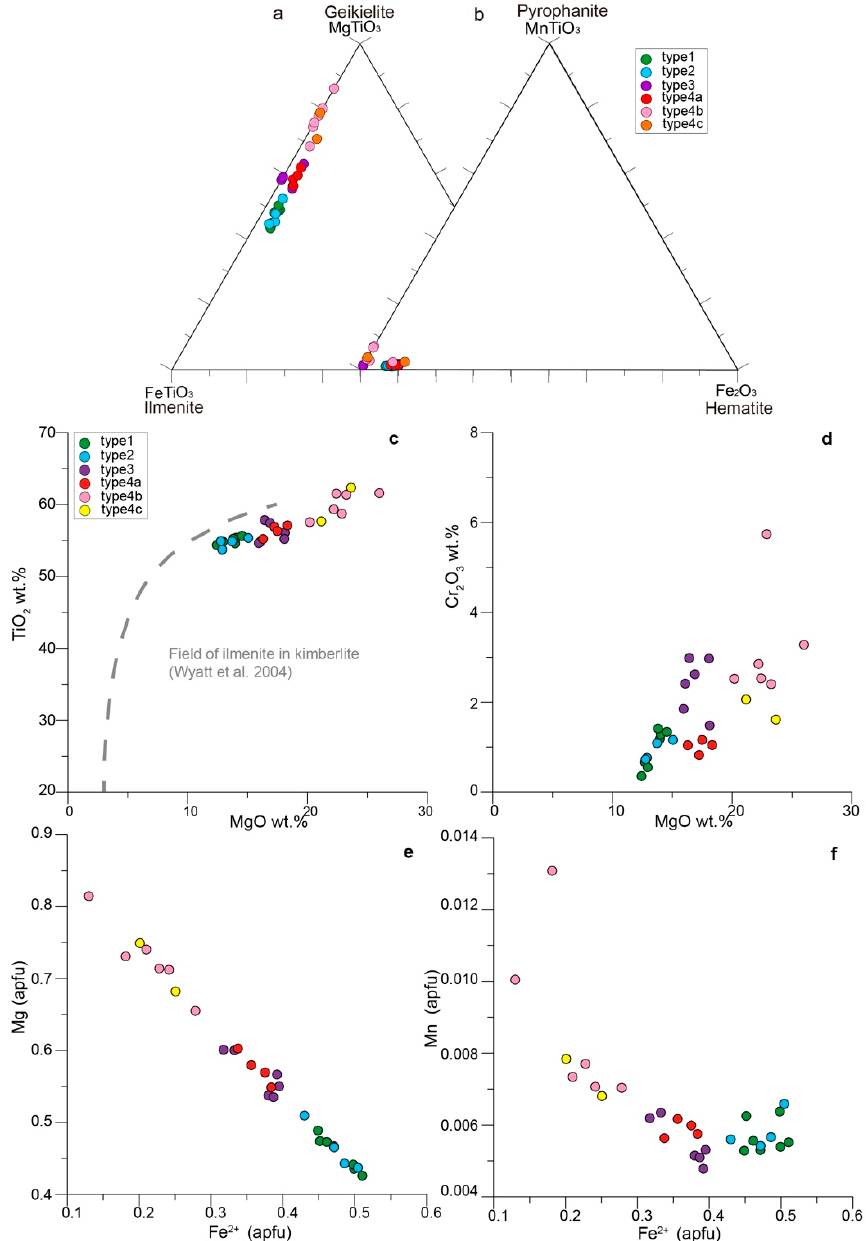
Figure 5. Composition of ilmenite-group minerals. Ternary plots of the di ff erent textural types (1 to 4) of ilmenite from Menominee: ( a ) in terms of the geikielite (MgTiO 3 )–ilmenite (FeTiO 3 )–hematite (Fe 2 O 3 ); ( b ) in terms of the pyrophanite (MnTiO 3 )–ilmenite (FeTiO 3 )–hematite (Fe 2 O 3 ) end members. Binary plots between the major elements analyzed in di ff erent types of ilmenite-group minerals described in the main text ( c – f ).